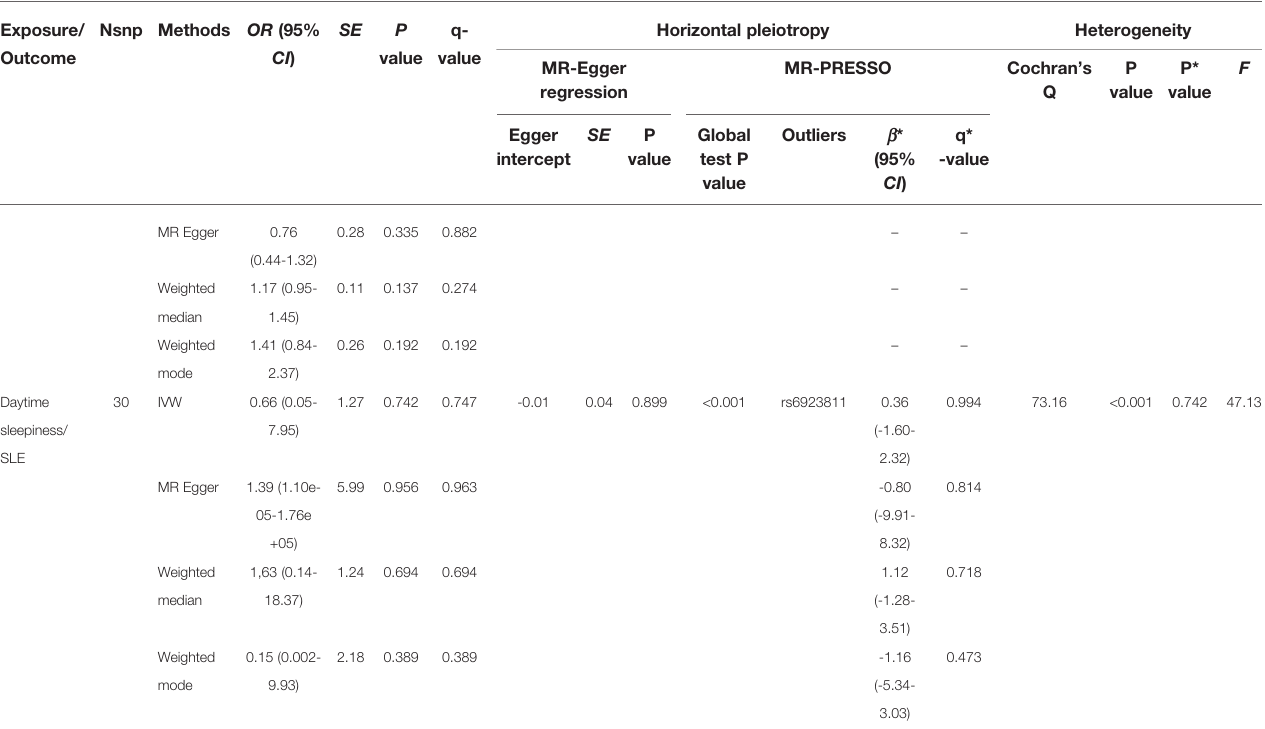
*The result of recalculation after removing outliers. MR-PRESSO, MR-Pleiotropy Residual Sum and Outlier method. OR, odds ratio; CI, con fi dence interval; IVW, inverse-variance weighted. q-value, P-value corrected for False Discovery